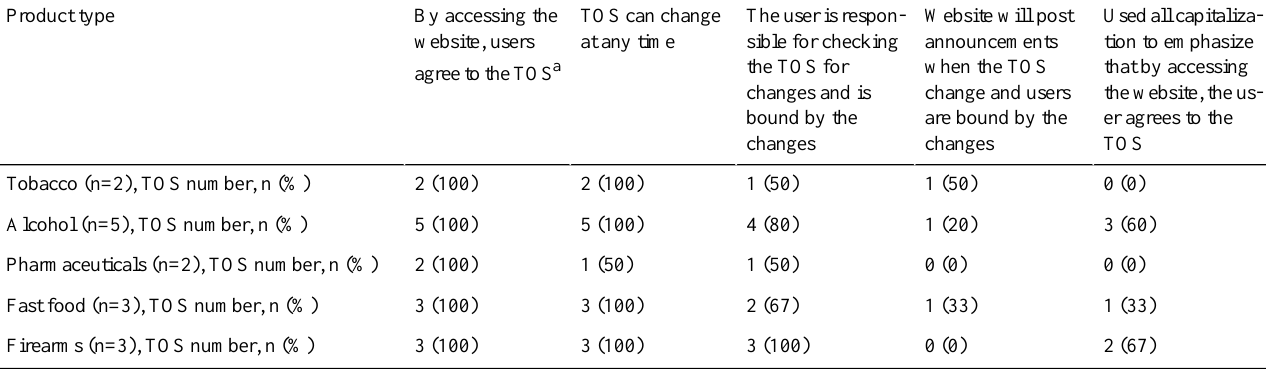
Table 3. Accepting terms of service and the possibility of changing terms by accessing websites.